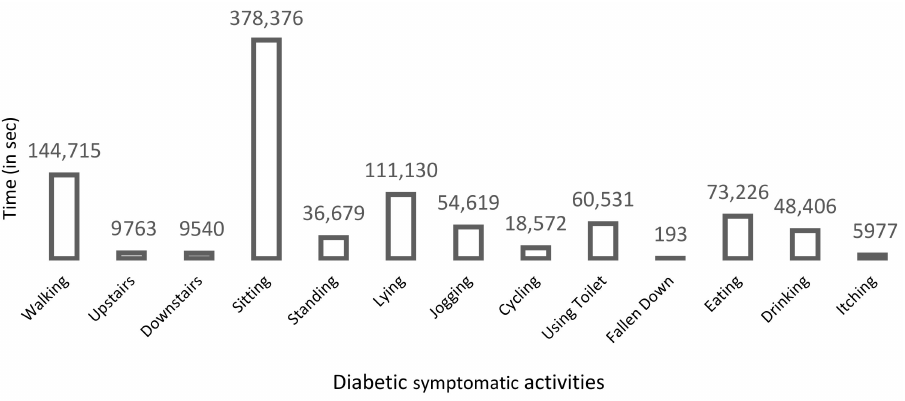
Figure 7. Activities performed by the target subject over thirty persistent